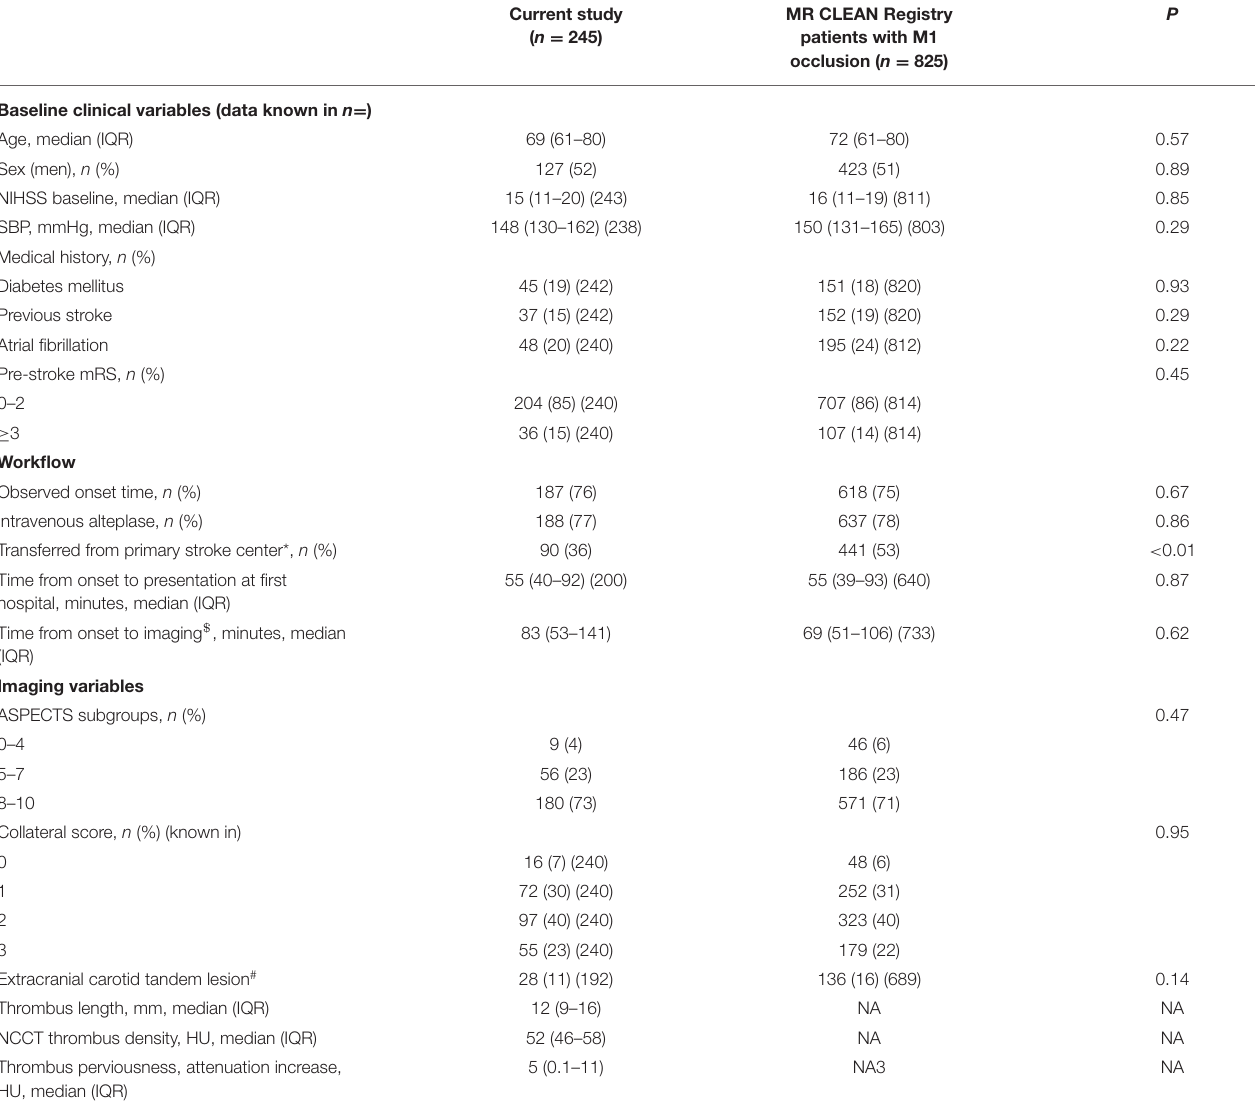
TABLE 1 | Baseline characteristics of patients included in the current study, compared to all MR CLEAN Registry patients with an M1 occlusion.